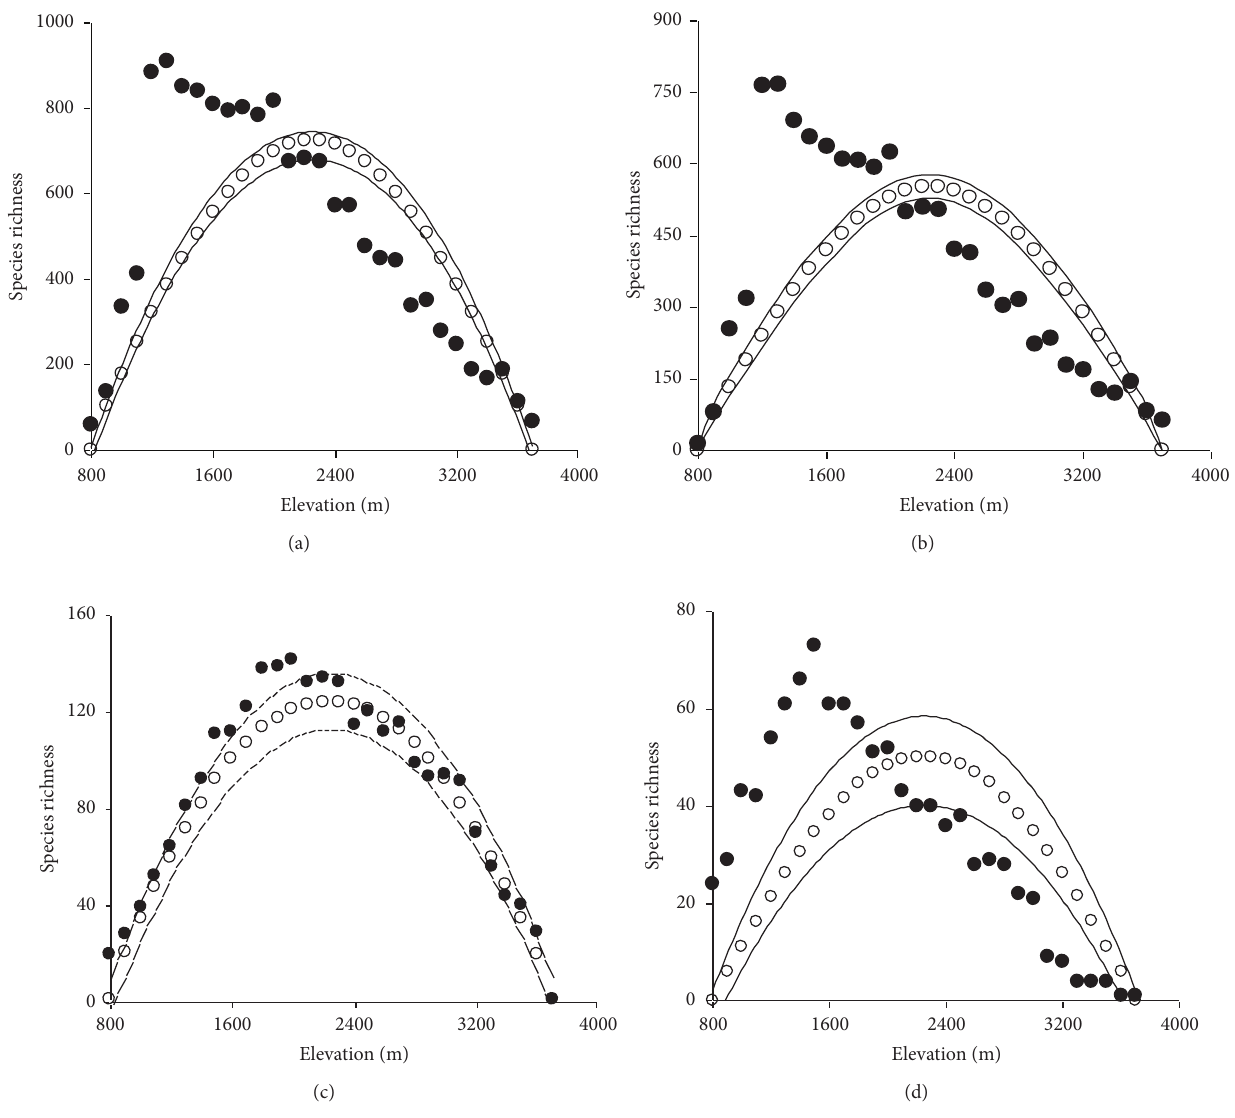
Figure 4: Elevational patterns of observed species richness and predicted richness (computed from 5,000 randomizations) in Taibai Mountain. Dot represents observed richness, solid line represents predicted richness by RangeModel based on middomain effect, and dashed lines represent the interval of predicted richness with 95% confidential. Overall plants (a), seed plants (b), bryophyte (c), and fern